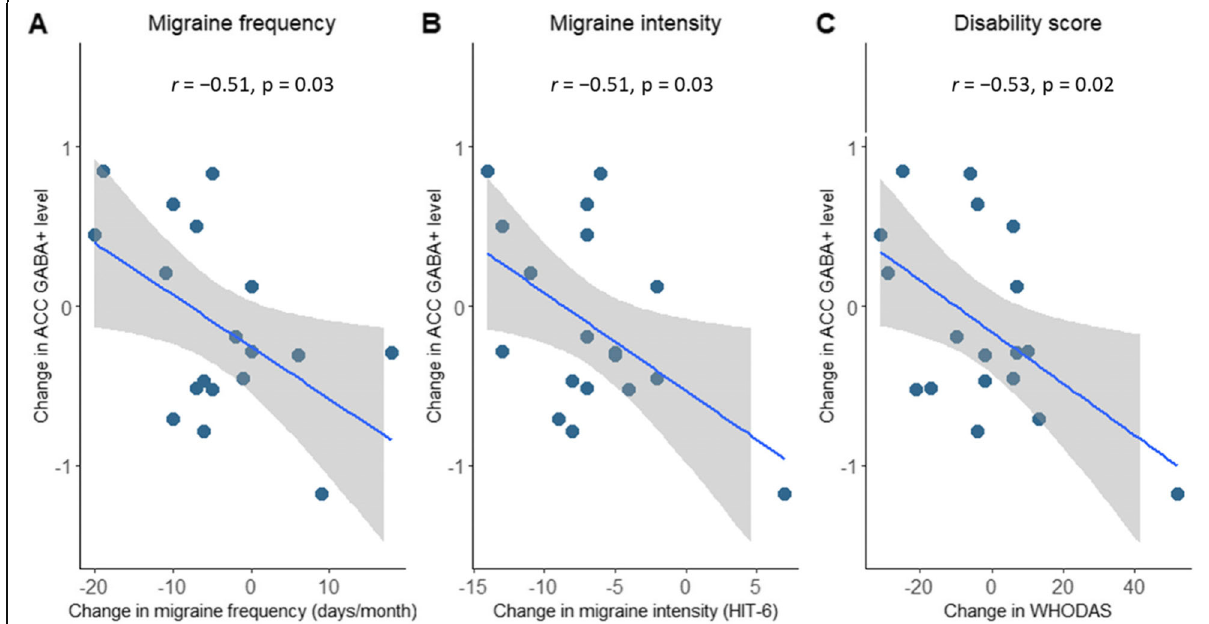
Fig. 4 Correlation between change in ACC GABA+ and change in clinical characteristics. Dots represent participants with migraine, the grey ribbon represents the 95% confidence interval, and the blue regression line represents the Pearson ’ s correlation coefficient